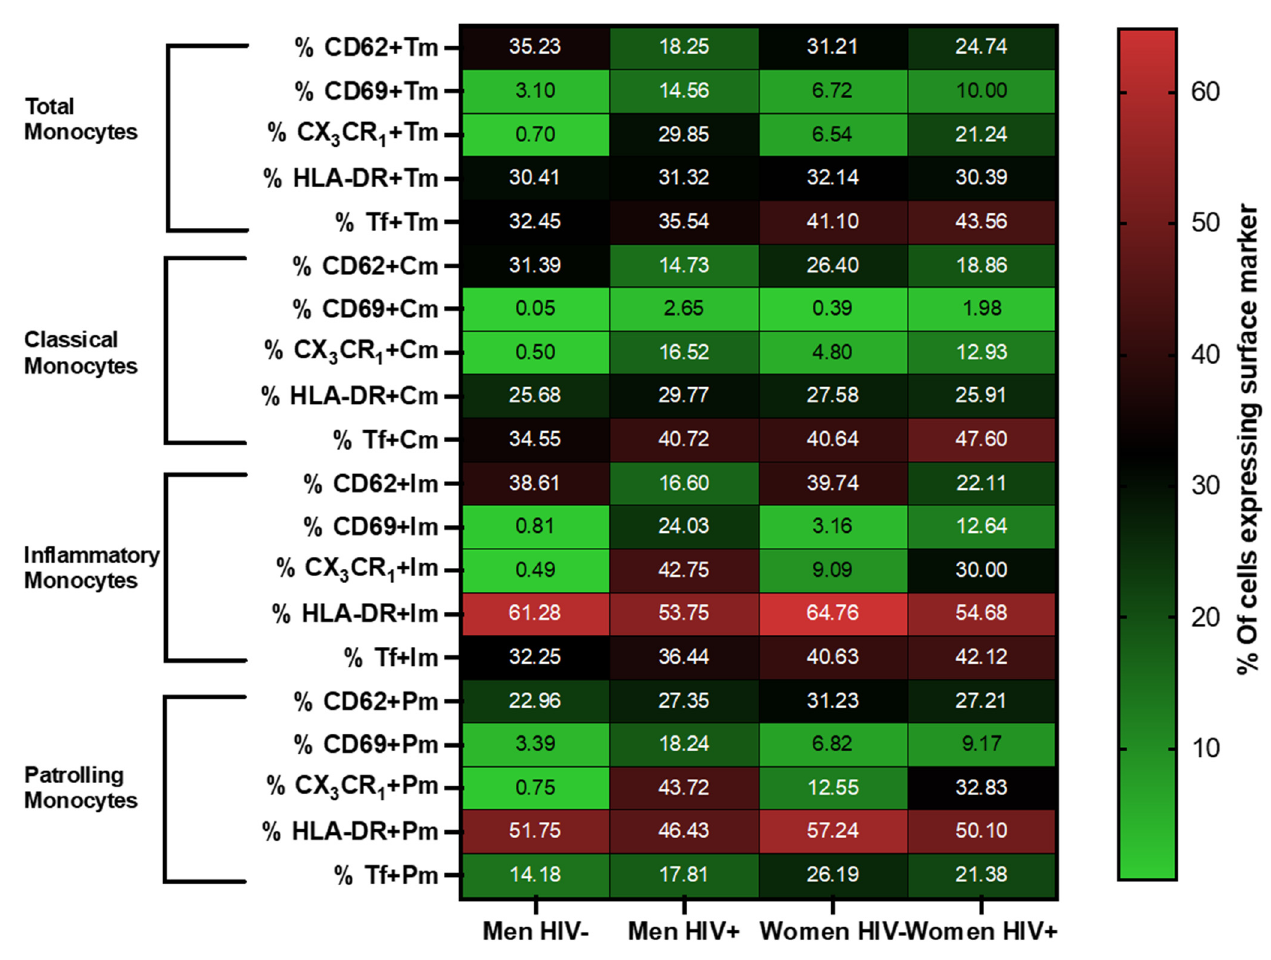
Figure 2. Monocyte phenotyping by sex/HIV status. Heat map depicting the percentage of expression of CD62p, CD69, CX3CR1, HLA-DR, and tissue factor in total, classical, inflammatory, and patrolling monocytes (Y axis) by sex/HIV group (X axis). The numbers indicated within each box are the average percentage of cells expressing the surface marker indicated in the Y axis, for the given sex/HIV group indicated in the X axis.